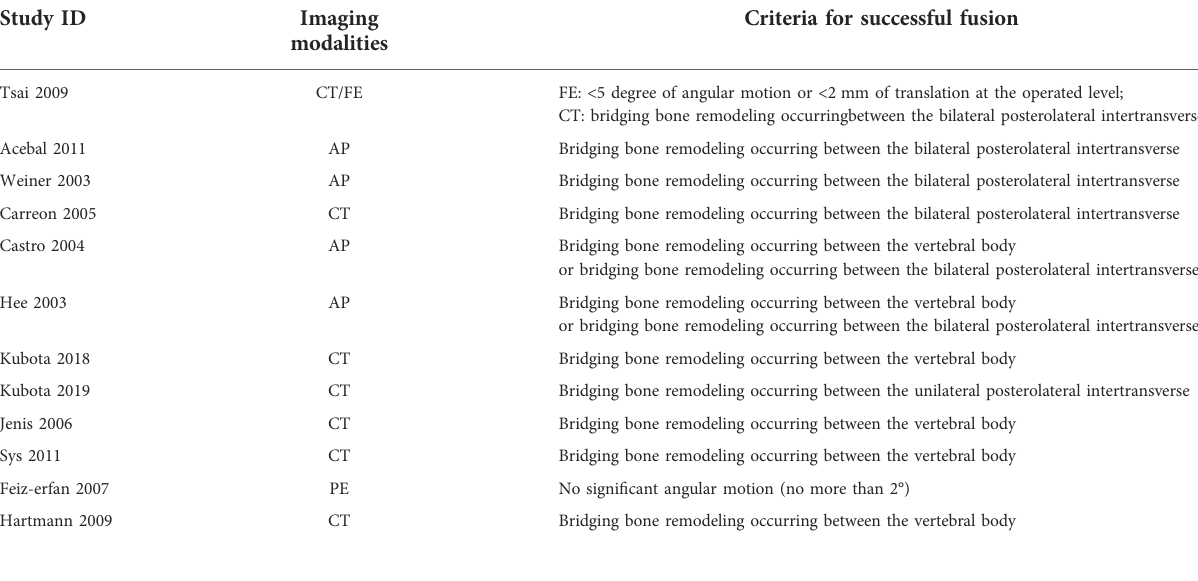
TABLE 2 Criteria and evaluation methods for successful spinal fusion in each